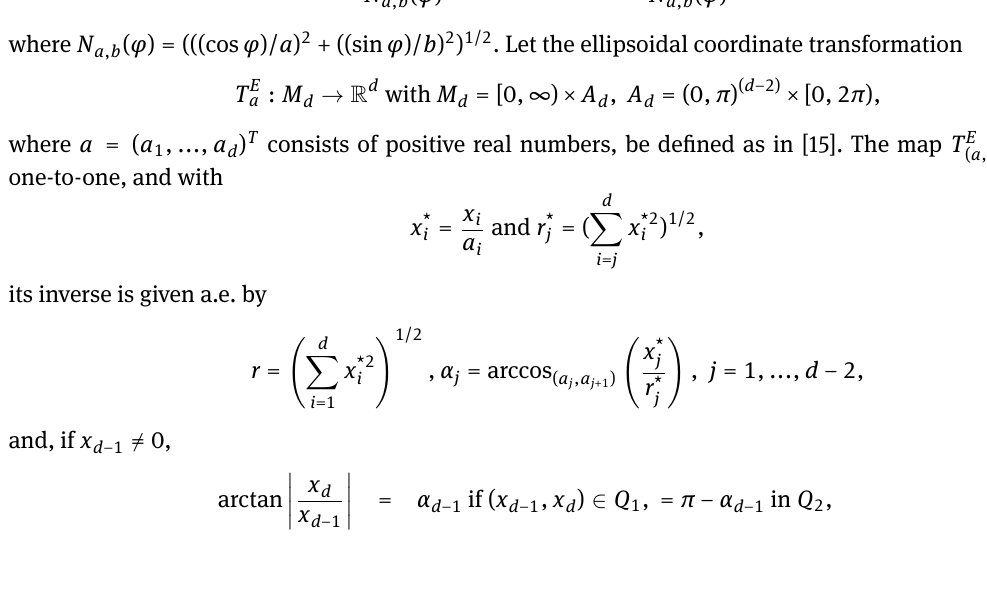
In case that B = { x ∈ R d : (cid:107) x (cid:107) ≤ 1 } , Model class 3 may directly be generalized to the multivariate case, 2 meaning that equations (19) up to (22) are valid also for x ∈ R d with the norms correspondingly defined